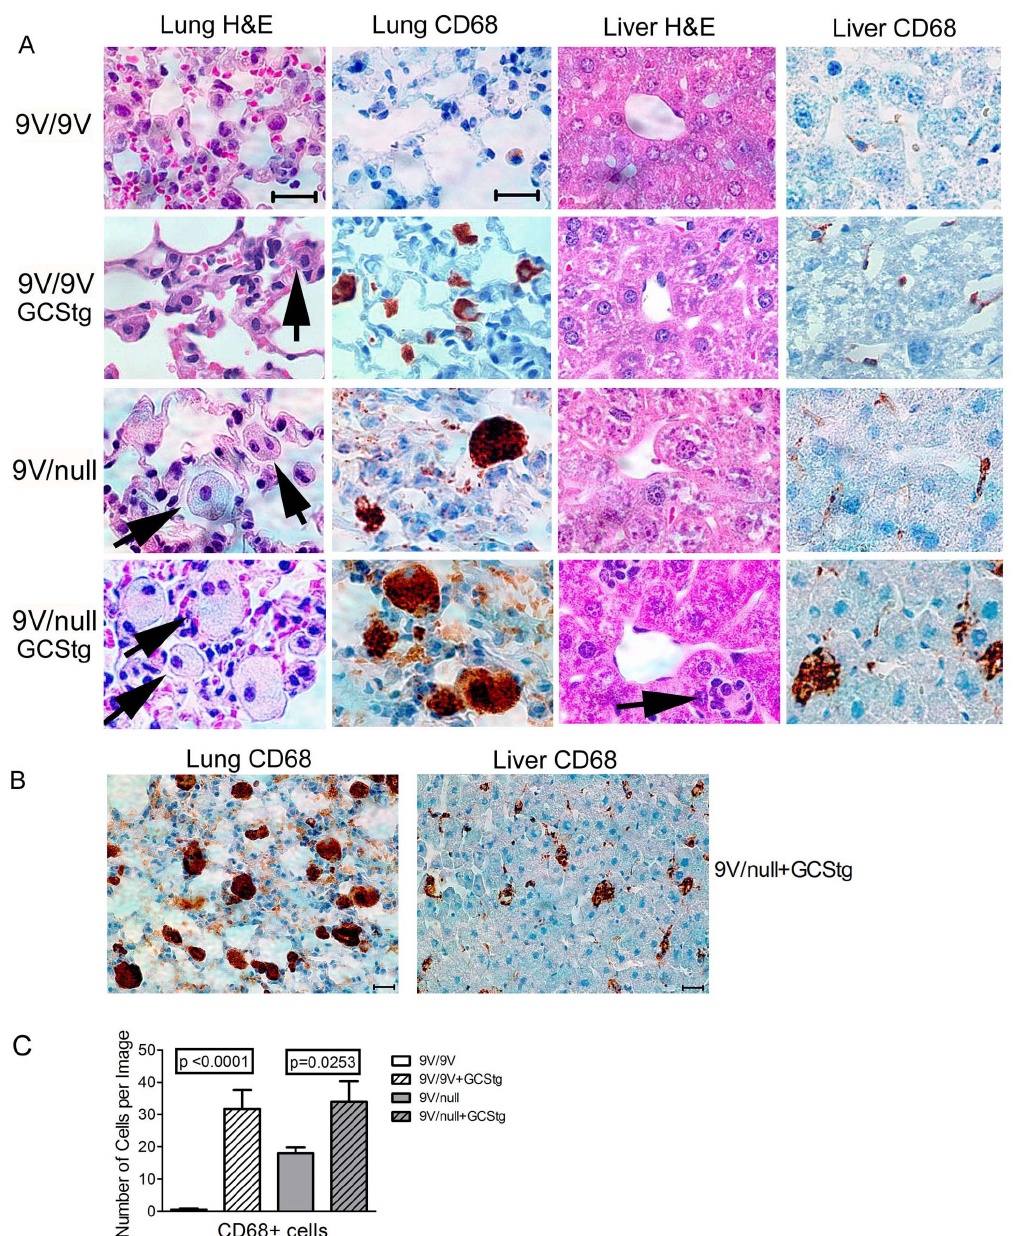
Fig. 5. Histology in 9V/9V/GCStg and 9V/null/GCStg mice. (A) The lung and liver sections from 9-wk old 9V/9V (row 1), 9V/9V/GCStg (row 2), 9V/null (row 3) and 9V/null/GCStg (row 4) were processed for H&E and CD68 antibody staining as indicated. Large and pale storage cells were observed in H&E stained lung and liver sections (arrows). The macrophages were indicated by anti-CD68 immunostaining (brown). Images were captured by Zeiss microscope with Spot Advance software. Scale bar was 40 m m for all images. (B) The distribution and density of macrophages in 9V/null/GCStg lung and liver immunostained by anti-CD68 antibody (brown). Scale bar was 40 m m for both images. (C) CD68 positive cells (CD68 + ) in 9V/9V/GCStg and 9V/null/GCStg lungs had significantly more CD68 stained macrophages than 9V/9Vand 9V/null at 9 wks of age, respectively. The data present number of cells per image of total 5 2 15 images/mouse, 3 mice per genotype. Results with error bars are mean ¡ S.E. The p values were from Student’s t-test.